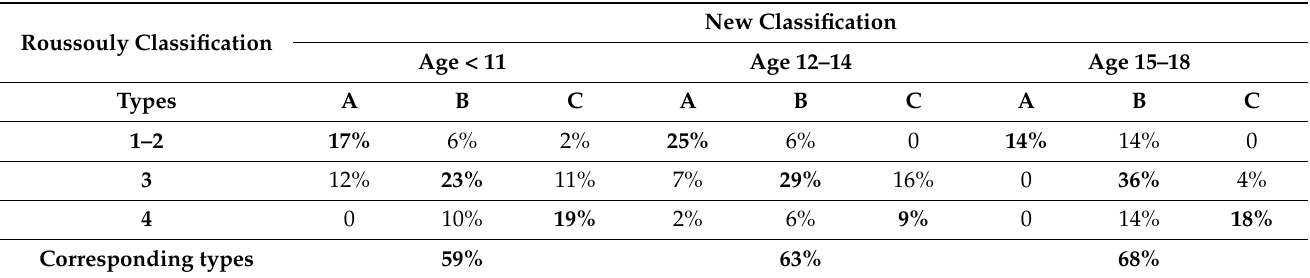
Table 5. Correlations between the growing age Roussouly classification and the new classification among the different groups. Theoretically, the corresponding types between the two classifications should be A with 1–2, B with 3 and C with 4, respectively. The last line reports the “correct” corresponding types. With growth the two classifications become